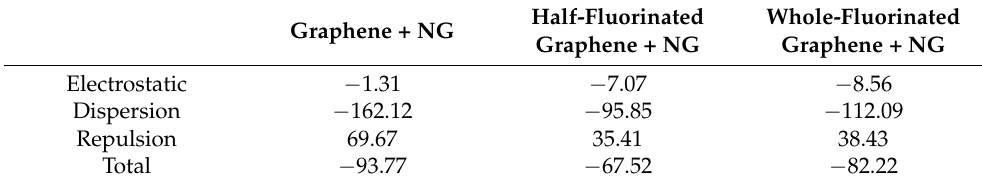
Table 2. The results of the energy decomposition analysis based on the AMBER forcefield.